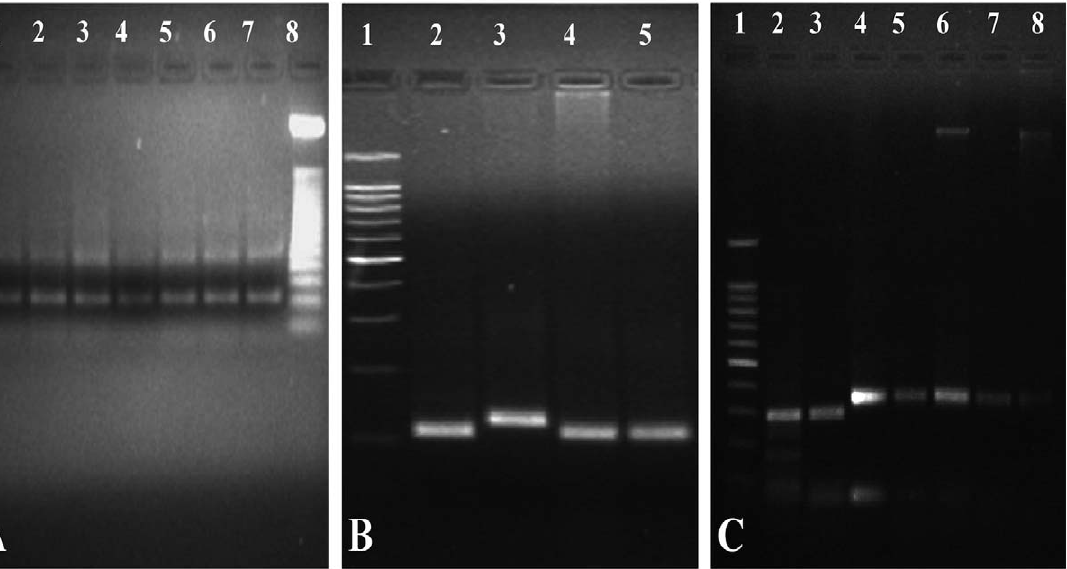
Figure 2. Amplification products of the DNAst, intergenic region of mini-exon gene and 24S a rDNA region performed. Figure 2A. Amplification product in 2% agarose gels of DNAst. Lane 1-6 Patients 111- 116 TcII-TcVI, Lane 7. Patient 87, Lane 8. 50-bp Weight Marker. Figure 2B. Amplification product in 2% agarose gels of the D7 24S a rDNA region. Lane 9. 100-bp Weight Marker, Lane 10. Patient 87 TcI, Lane 11. Patient 98 TcII- TcVI, Lane 12–13. Patients 101-107 TcI. Figure 2C. Amplification product in 2% agarose gels of the intergenic regio´n of mini-exon gene. Lane 1. 100-bp Weight Marker, Lane 2. Patient 12 TcII-TcVI, Lane 3. Patient 34 TcII-TcVI, Lane 4–8. Patients 33-34-35-36 TcI.